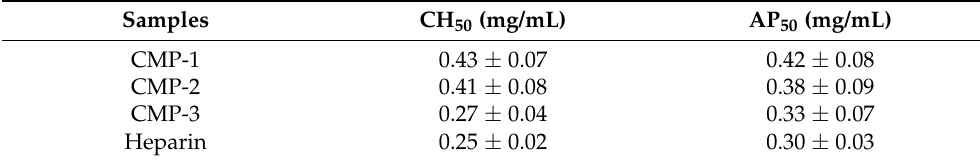
Figure 8. The anti-complementary activity of three polysaccharides with different dilution concentra- tions through CP ( a ) and AP ( b ). Comparison of CH 50 ( c ) and AP 50 ( d ). (NS: not significant, * p < 0.05, ** p < 0.01 and *** p < 0.001). Table 2. The anti-complementary activity of CMP-1, CMP-2 and CMP-3.